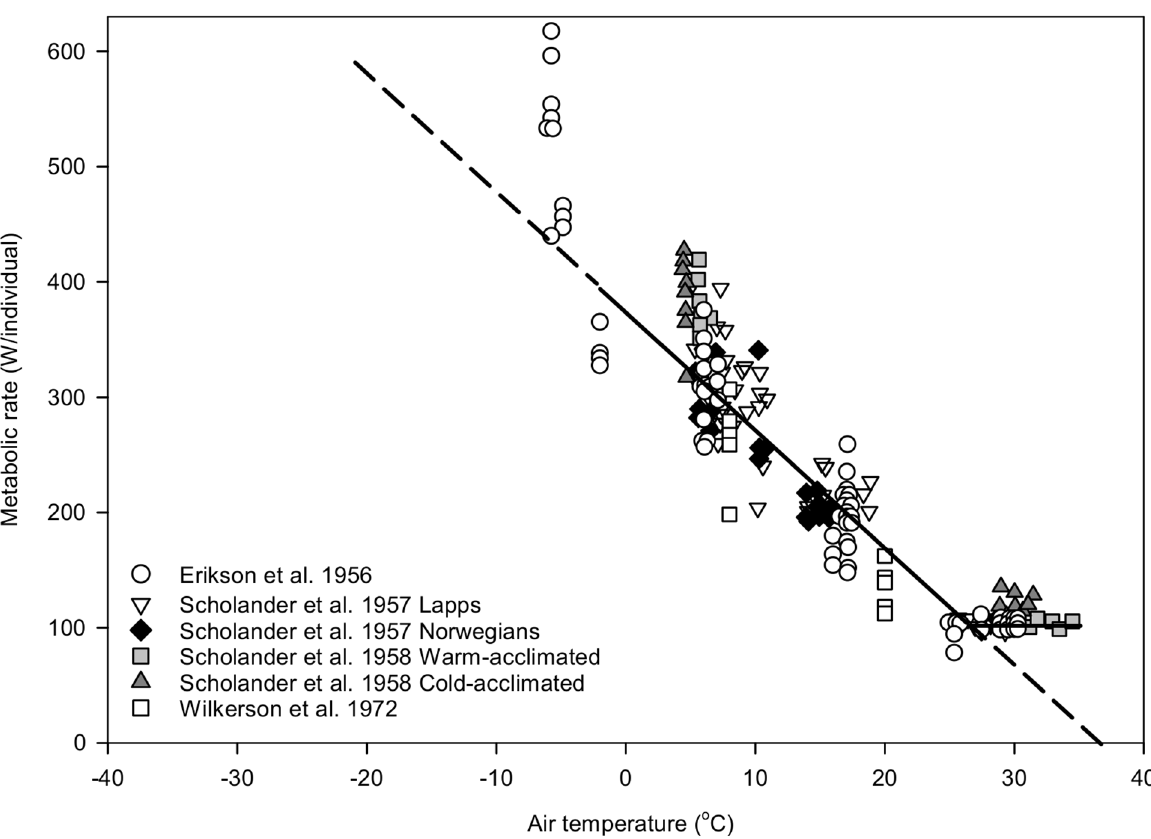
Figure 3. Meta-analysis of metabolic cost of thermoregulation in naked men: metabolic rate per person as a function of ambient temperature ( T a ). Men wore skimpy shorts and in some cases shoes (to peddle an ergometer). Values at T a ,2 3 u C were excluded from the regression analysis because subjects were notably uncomfortable under such cold conditions. Original papers presented metabolic rates as percentages of basal or resting metabolic rates, i.e., 100 = basal or resting rate, 200 = twice basal or resting, etc. Linear least-squares regression was carried out in this scaling domain: Metabolic rate as percentage of basal or resting = 2 9.812 ( T a 2 37) (r 2 =0.98). For this plot, a 178-cm-tall, 70-kg subject (body surface area = 1.8 m 2 ) [39] with resting metabolic rate = 1 met (50 kcal m 2 2 h 2 1 =58 W m 2 2 ) [20] is assumed. A basal or resting metabolic rate of 104 W is thus assumed: Metabolic rate (W/individual) = 2 10.27 ( T a 2 37). Citations: Erikson et al. 1956 [16]; Scholander et al.1957 [17]; Scholander et al.1958 [18]; Wilkerson et al. 1972 [19].